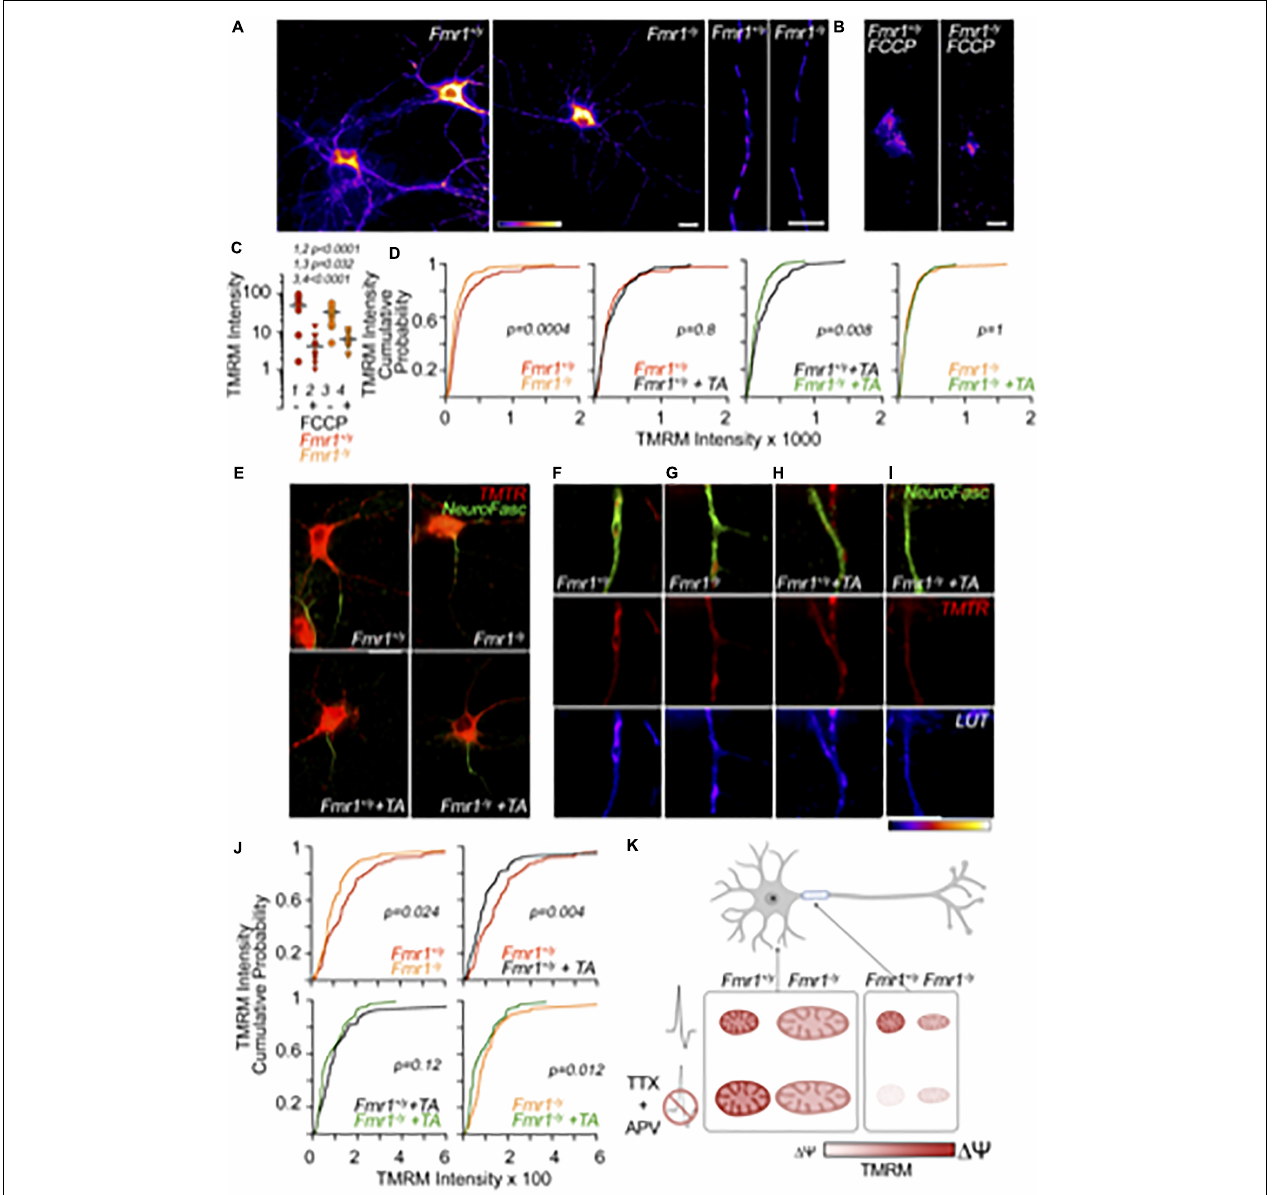
FIGURE 2 | Compartmentalized membrane potential modifications in WT and Fmr1 -KO mitochondria before and after activity deprivation. Layout: the top half of the figure comprises data on mitochondrial membrane potential in the dendrite. The bottom half of the figure comprises data on mitochondrial membrane potential in the AIS. The bottom right contains a summary diagram of the described results in Figure 1 . (A) Representative images of TMRM-labeled neurons. Scale bars = 20 µ m. From left: full neurons either in control conditions or after FCCP (0.5 µ M) treatment, representative dendritic segments. (B,C) FCCP treatment caused significantly reduced TMRM signals in dendritic mitochondria of both WT (1, 2) and Fmr1 KO (3, 4); + = FCCP, - = no FCCP. (D) TMRM intensity is significantly reduced in dendrites of Fmr1 KO compared to WT at baseline and after TTX/APV treatment. TMRM signal in dendrites was not affected by TTX/APV treatment in either genotype. (E) Representative images of co-labeled neurons with TMRM and AIS-specific marker neurofascin from all conditions. (F–I) Top: Representative images of neurofascin-positive neurites colocalizing with TMRM-labeled mitochondria. Middle: same neurite segment as in the top row but with the neurofascin stain removed to isolate the colocalizing TMRM-labeled mitochondria. Bottom: same images as above but pseudo-colored according to TMRM-labeled fluorescence intensity. Row (F) = WT, (G) = Fmr1 KO, (H) = WT + TTX/APV, (I) = Fmr1 KO + TTX/APV. (J) At baseline, AIS-residing Fmr1 -KO mitochondria display significantly reduced TMRM intensity. Following TTX/APV, mitochondria in the AIS significantly reduce their TMRM signal in both genotypes. However, the TTX/APV-induced reduction in TMRM signal is of greater magnitude in the WT compared to Fmr1 KO. N of analyzed dendrites: WT n = 210, Fmr1 KO n = 175, WT treated with TTX/APV n = 179, Fmr1 KO treated with TTX/APV n = 187. N of AIS: WT n = 75, Fmr1 KO n = 62, WT + TA n = 67, Fmr1 KO + TA n = 59. (K) Summary model: compartment-specific regulation of mitochondrial morphology and polarization by FMRP and activity deprivation. After TTX/APV, WT mitochondria are enlarged in the dendrites and depolarized in the AIS. At baseline, Fmr1 -KO neurons present with enlarged and/or elongated mitochondria in the dendrite and AIS, respectively, and mitochondria in both compartments display depolarized membrane potential. After TTX/APV, Fmr1 -KO mitochondria do not show changes in their size and only a slight further reduction in polarization. TA =